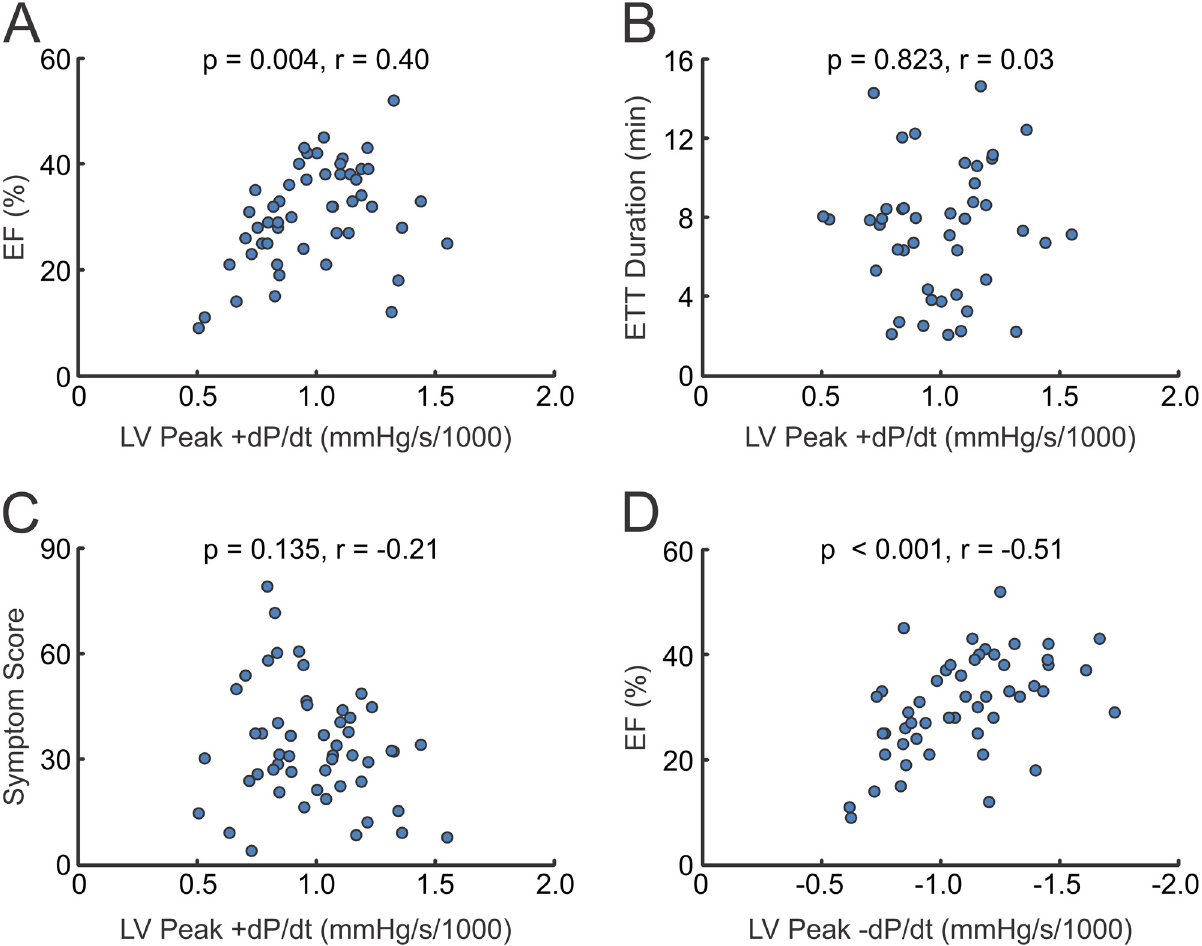
Fig 1. Selected Graphs of Correlations Between Tests of LV Function. Graphs represent Pearson ’ s correlations, with p-values and correlation coefficients (r) listed. EF, Ejection Fraction; ETT, Exercise Treadmill Test; LV, Left